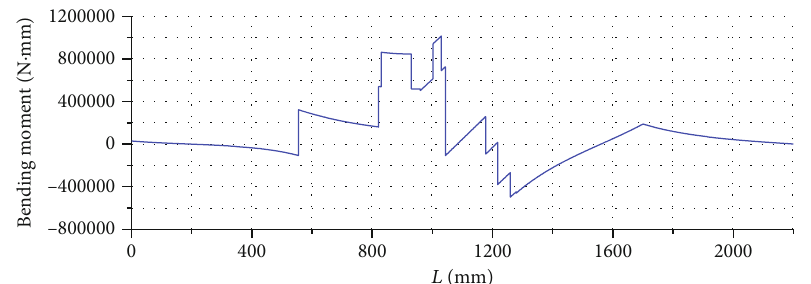
Figure 7: Bending moment diagram when the gross load is 130 MPa.